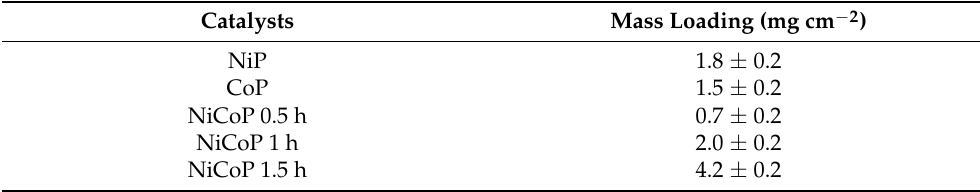
Figure 1. Electrodeposition synthesis procedure of NiCoP. Table 1. The mass load of the relevant catalyst.